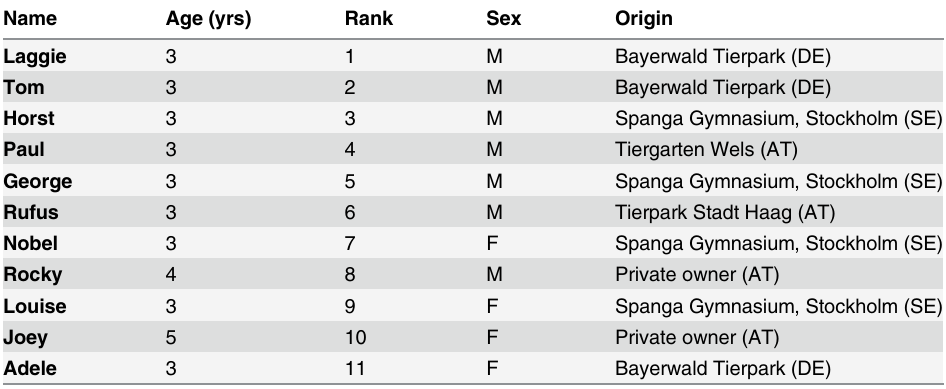
Table 1. Test subjects, their age, rank, sex and